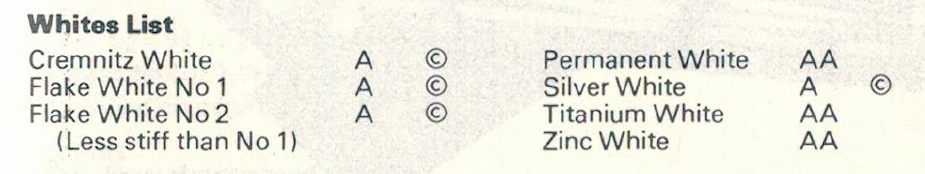
Figure A3. White oil colours listed in the catalogue of W&N from 1979.